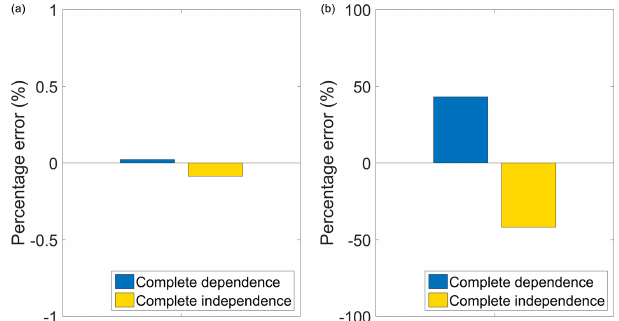
Figure 7. Percentage error in expected annual damage (EAD) (a) and in economic damage for the 200-year event (b) under the as- sumptions of complete dependence and complete independence for the entire Elbe